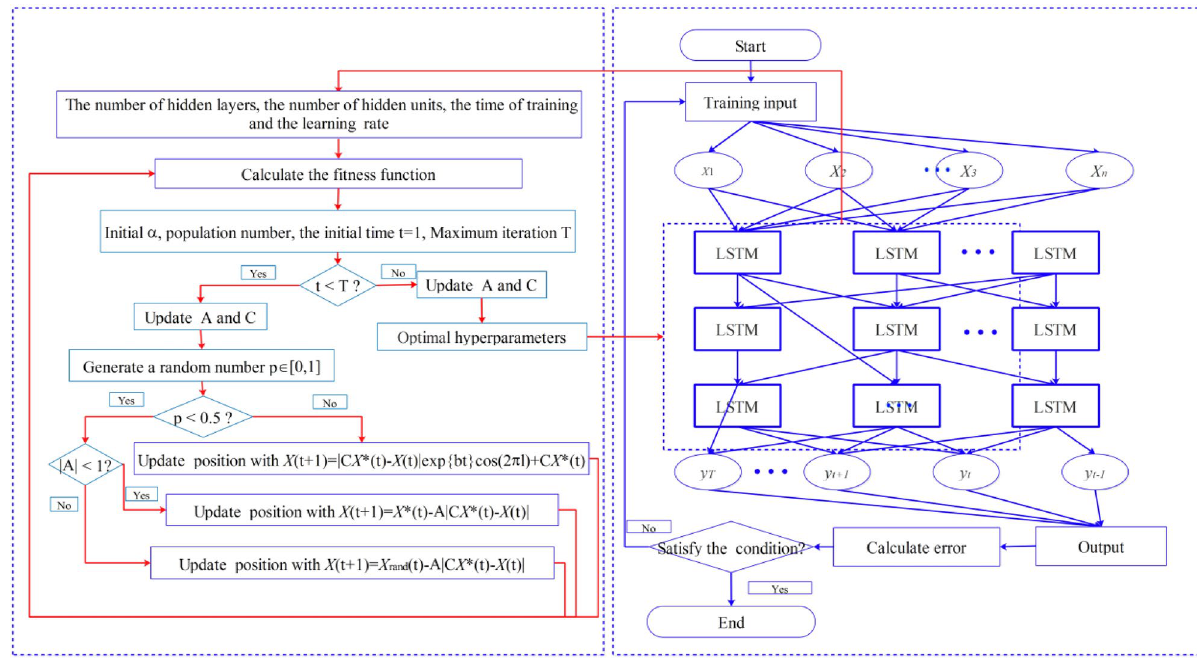
Figure 2. The flowchart of the WOA-LSTM.